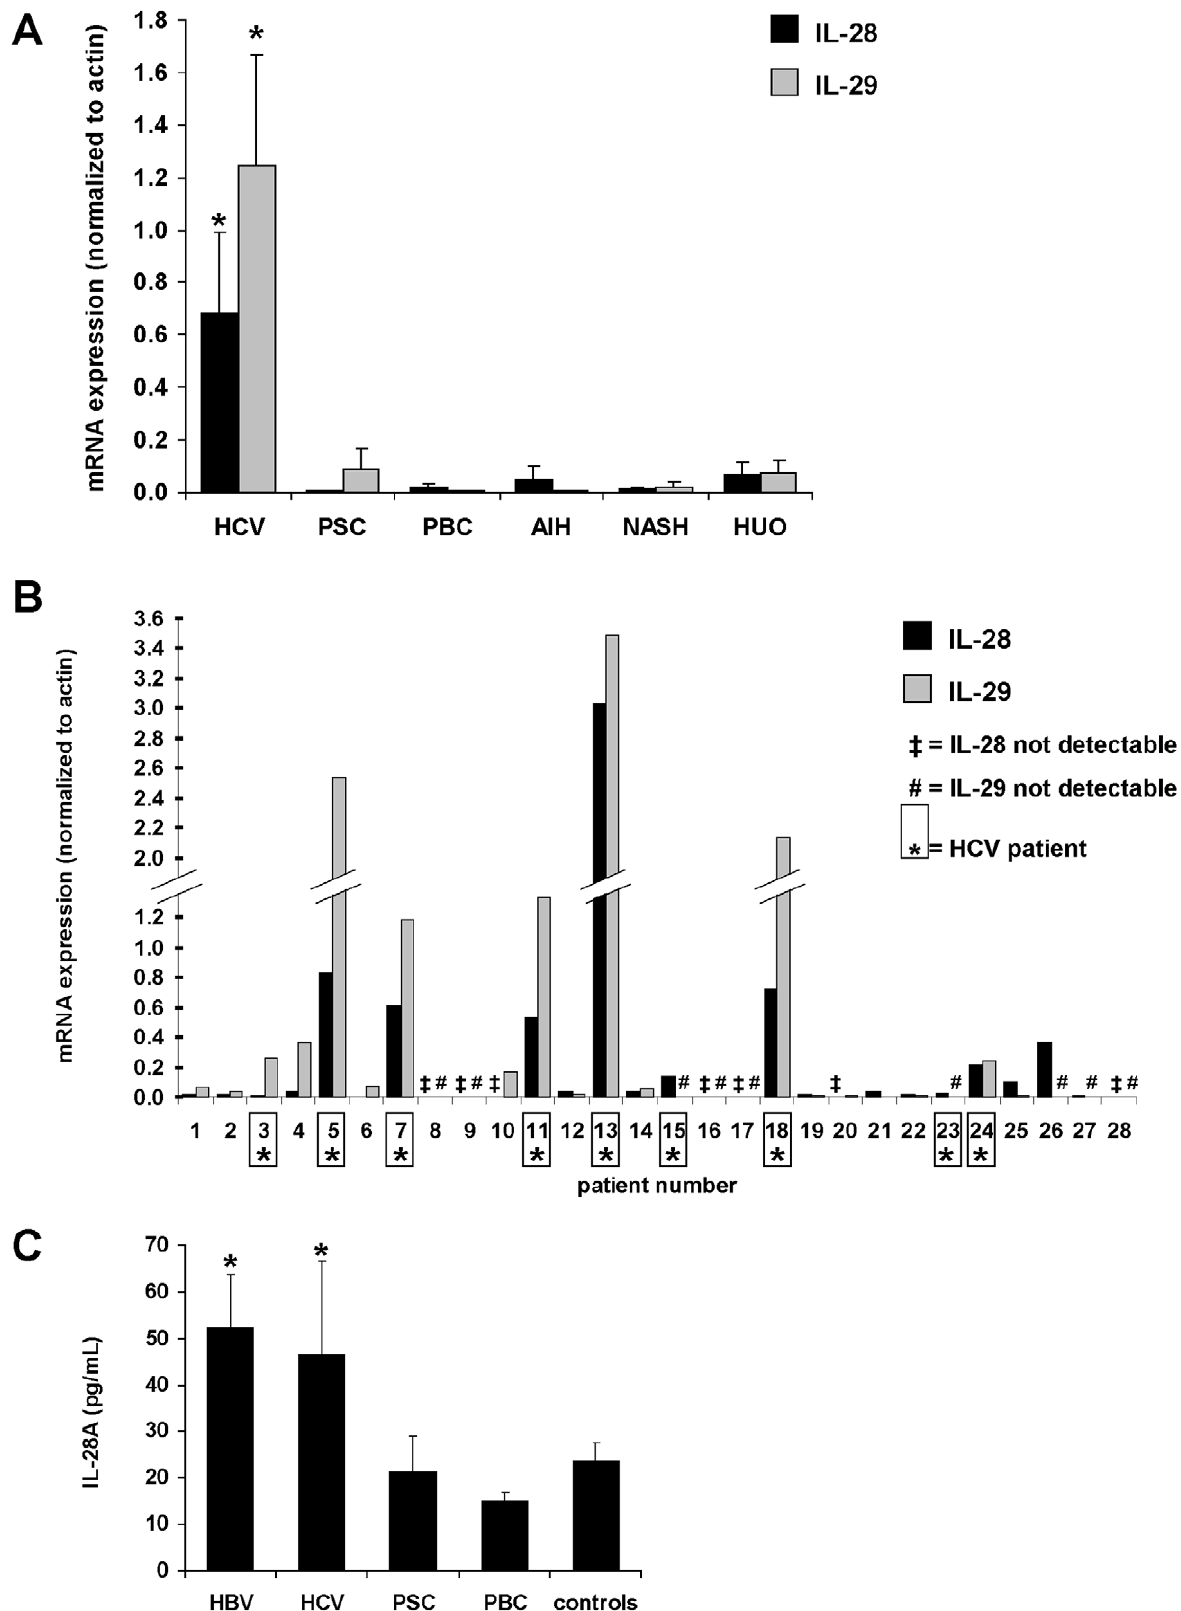
Figure 5. Expression of IL-28A and IL-29 is significantly increased in human hepatitis C infection. (A) Total IL-28A/B expression in liver biopsies from HCV patients (n=9) is 18.4-fold higher in comparison to patients with other liver diseases such as primary sclerosing cholangitis, (PSC; n=2), primary biliary cholangitis (PBC; n=2), autoimmune hepatitis (AIH; n=2), non-alcoholic steatosis hepatis (NASH; n=3), or hepatitis of unknown